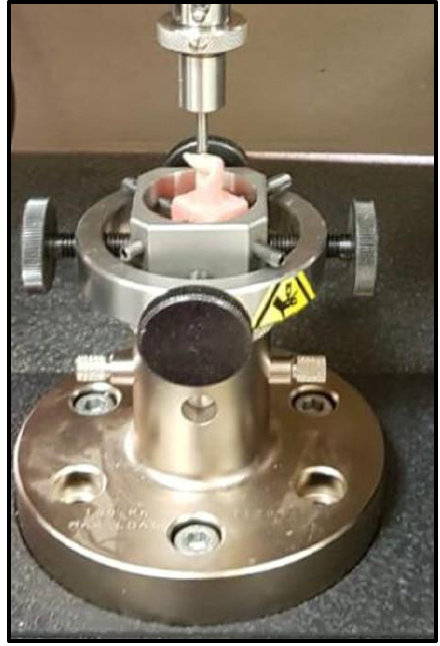
Figure 5. Specimen subjected to testing in a universal testing machine. Mean compressive stress (MPa) at maximum compressive load and mean maximum load (N) were compared between all the groups using the one-way analysis of variance